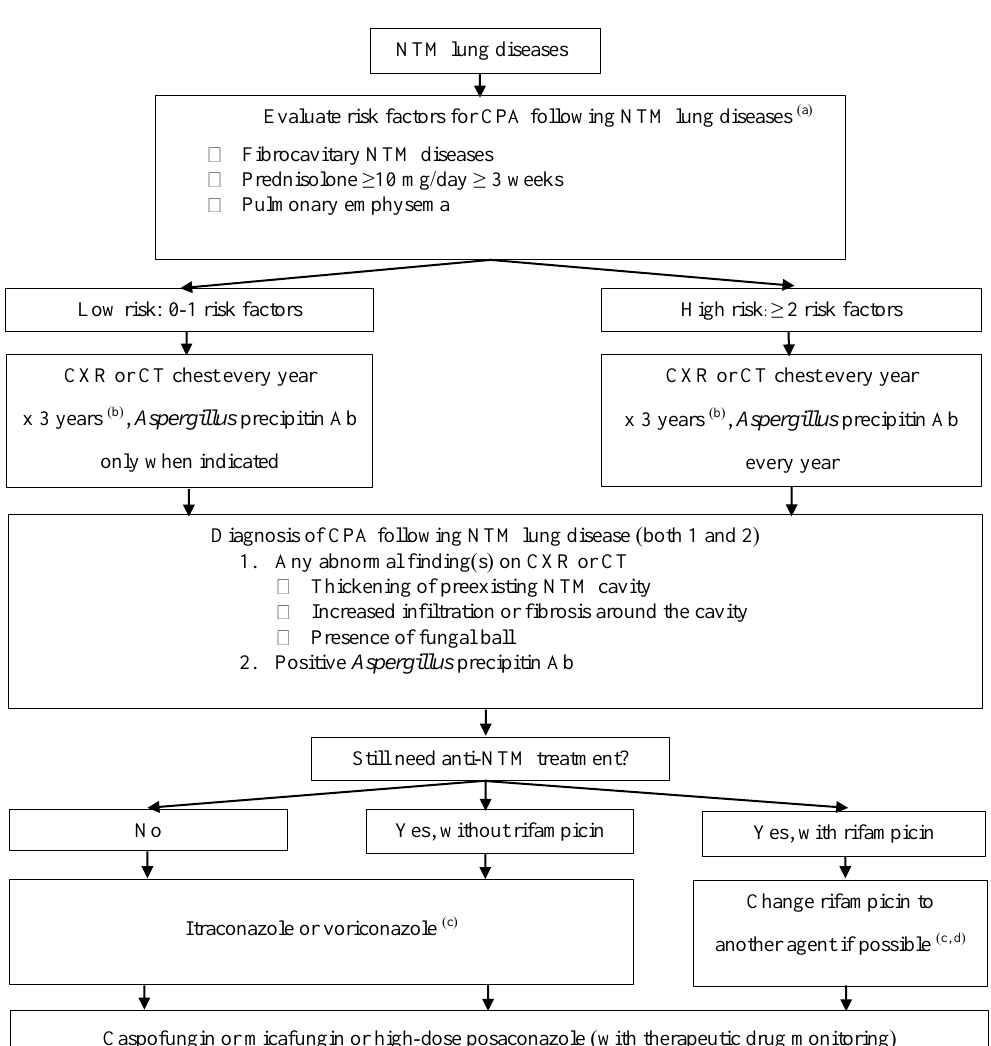
Figure 2. Proposed algorithm for diagnosis and treatment of CPA following NTM lung diseases. (a) The strongest risk factors were selected based on previous studies. (b) Three years were recommended based on previous data that most cases of CPA occurred within 3 years after NTM diagnosis. (c) Triazoles should be started 2 weeks after rifampicin discontinuation. (d) Rifampicin should be discontinued to avoid drug interaction if possible, since prognosis relies on CPA rather than NTM lung